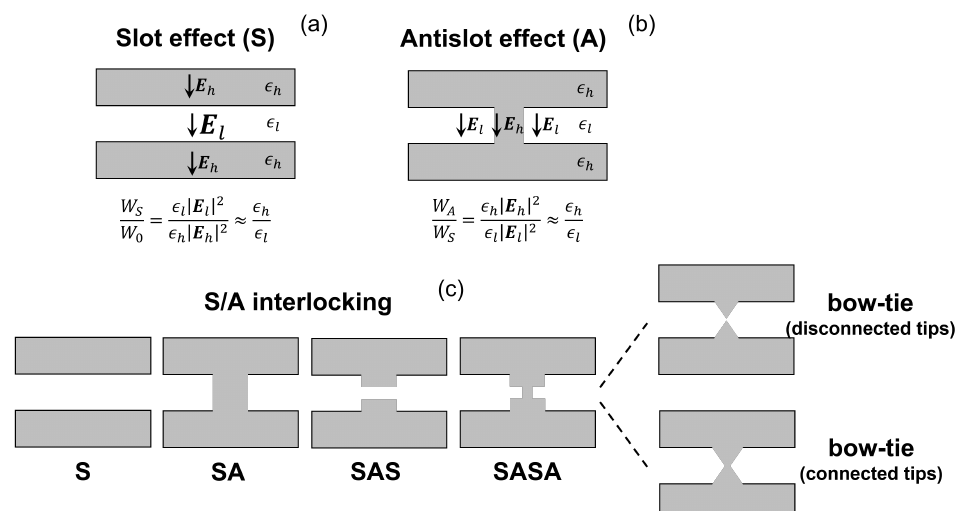
Figure 16. ( a ) Slot and ( b ) antislot effect to enhance the electric energy density. ( c ) Interlocking of slots and antislots leading to a bow-tie with either disconnected or connected